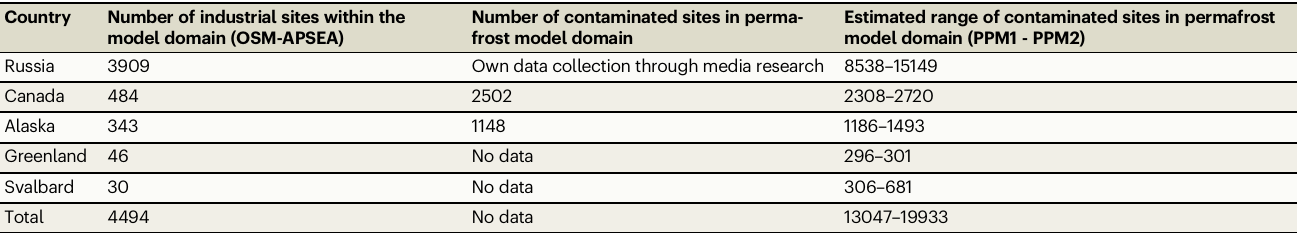
Table 1 | Numbers of industrial and contaminated sites within the permafrost dominated region of the Arctic Country Number of industrial sites within the Number of contaminated sites in perma- model domain (OSM-APSEA) frost model